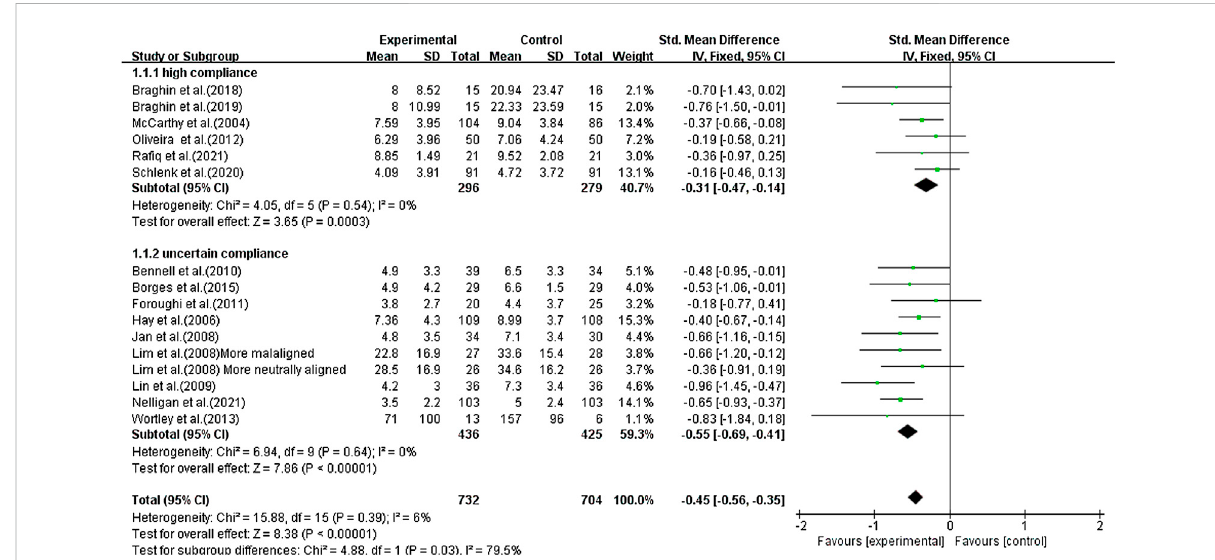
FIGURE 4 Forest plot of comparison: high versus uncertain, outcome: 1.1 Pain. Effect of land-based exercise compared to control when pain outcomes were assessed using the WOMAC pain subscale or NRS. Data are presented as standardized mean differences, with differences < 0 favoring land-